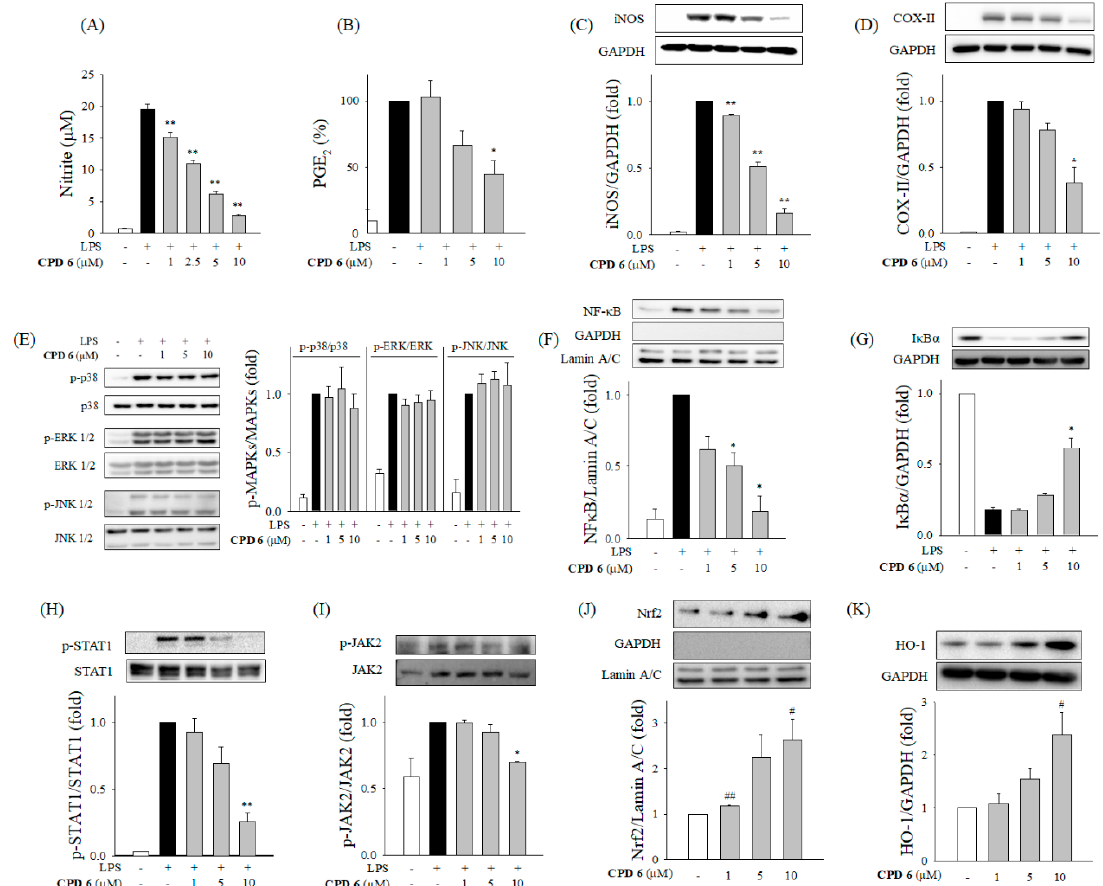
Figure 2. Anti-inflammatory effect of CPD 6 in LPS-activated macrophages and the responsible signaling pathways. ( A and B ) Effects of CPD 6 on the release of NO ( A ) and PGE 2 ( B ) were examined after 24 h LPS challenge in RAW 264.7 cells using the Griess reagent and ELISA, respectively. ( C and D ) The protein levels of iNOS ( C ) and COX-II ( D ) were measured by western blot. ( E ) Macrophages were stimulated by LPS for 1 h to determine phosphorylation of the MAPKs (p38, ERK, and JNK) in the presence or absence of CPD 6. ( F and G ) Effect of CPD 6 on NF κ B nuclear translocation ( F ) or I κ B α degradation ( G ) was measured after LPS treatment for 1 h 30 min, respectively. ( H and I ) Macrophages were challenged with LPS in the presence or absence of CPD 6 for 6 h to measure phosphorylated level of STAT1 ( H ) and for 2 h to measure phosphorylated JAK2 ( I ). ( J and K ) Nrf2 nuclear translocation ( J ) and HO-1 expression ( K ) were measured after CPD 6 treatment without LPS stimulation for 6 h and 24 h, respectively. GAPDH and Lamin A/C were used as internal controls for the cytoplasmic and nuclear fractions, respectively. Data are expressed as mean ± SEM, * p < 0.05, ** p < 0.01 vs. LPS-treated group. # p < 0.05, ## p < 0.01 vs. control group. N = 3 or 4.